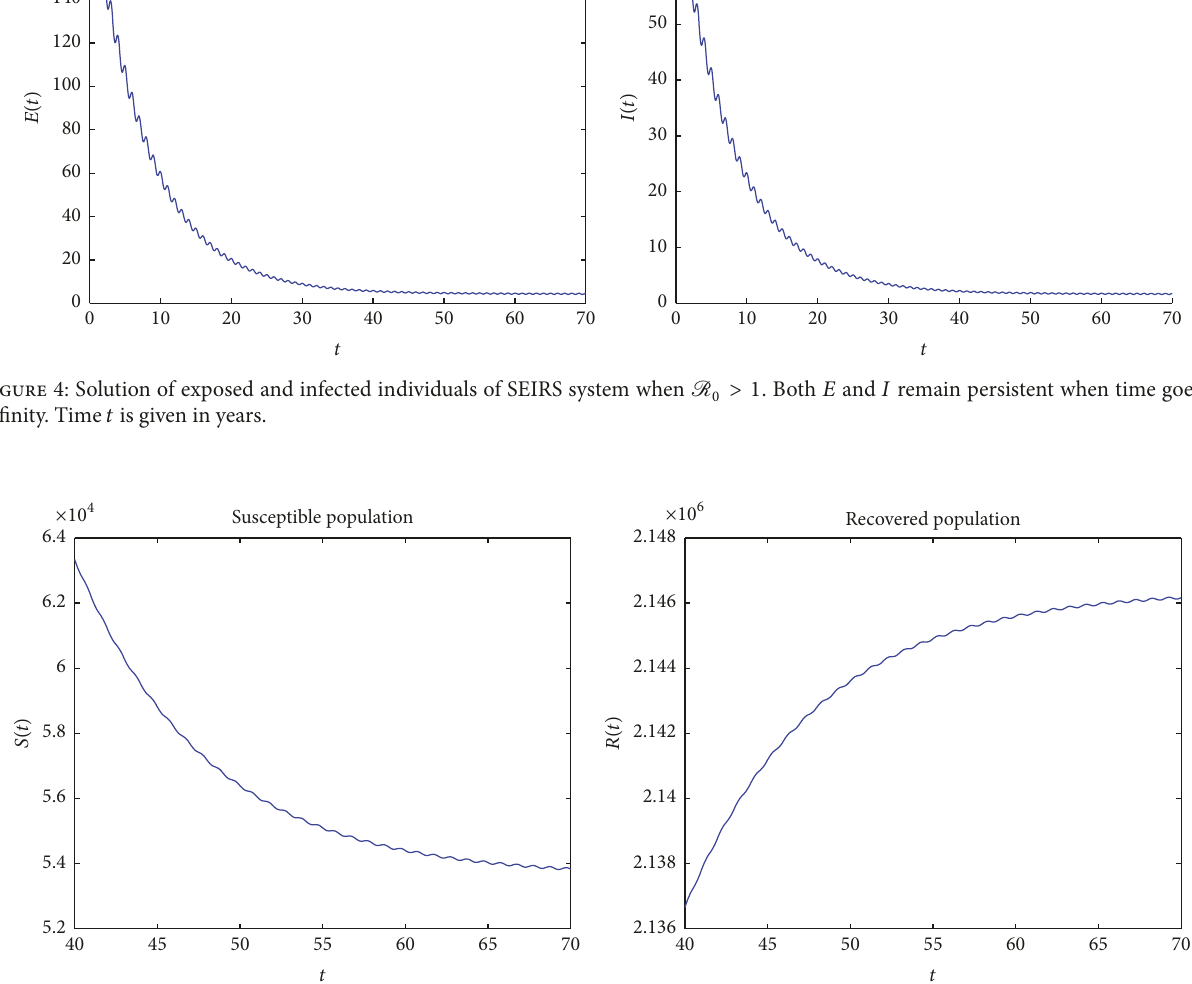
Figure 5: Solution of susceptible and recovered populations of SEIRS system when R 0 > 1 . Time 𝑡 is given in